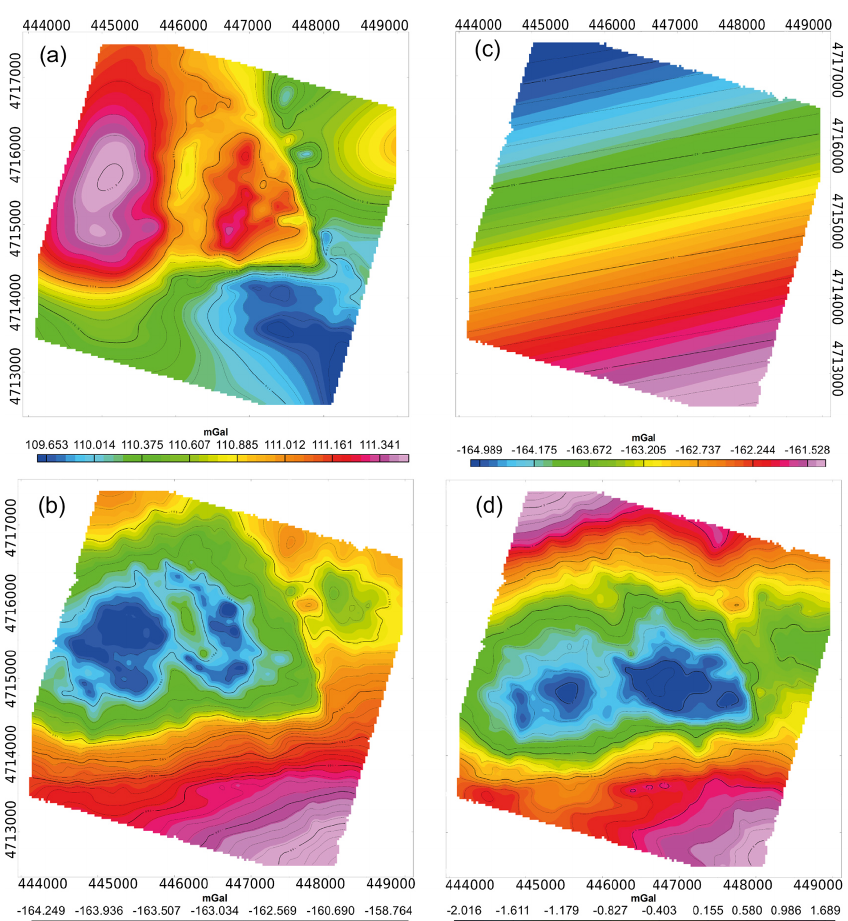
Figure 7. (a) Gravity response of the sedimentary sequence as imaged by Alcalde et al. (2014) and by the 2-D models presented in Fig. 5a and c, (b) regional component of the BA in Fig. 3, (c) gravity residual anomaly resulting from subtracting the map in (a) to the BA map in Fig. 3 and (d) final anomaly grid resulting from subtracting the map in (b) to that in (c) . This grid will be the one used for inversion